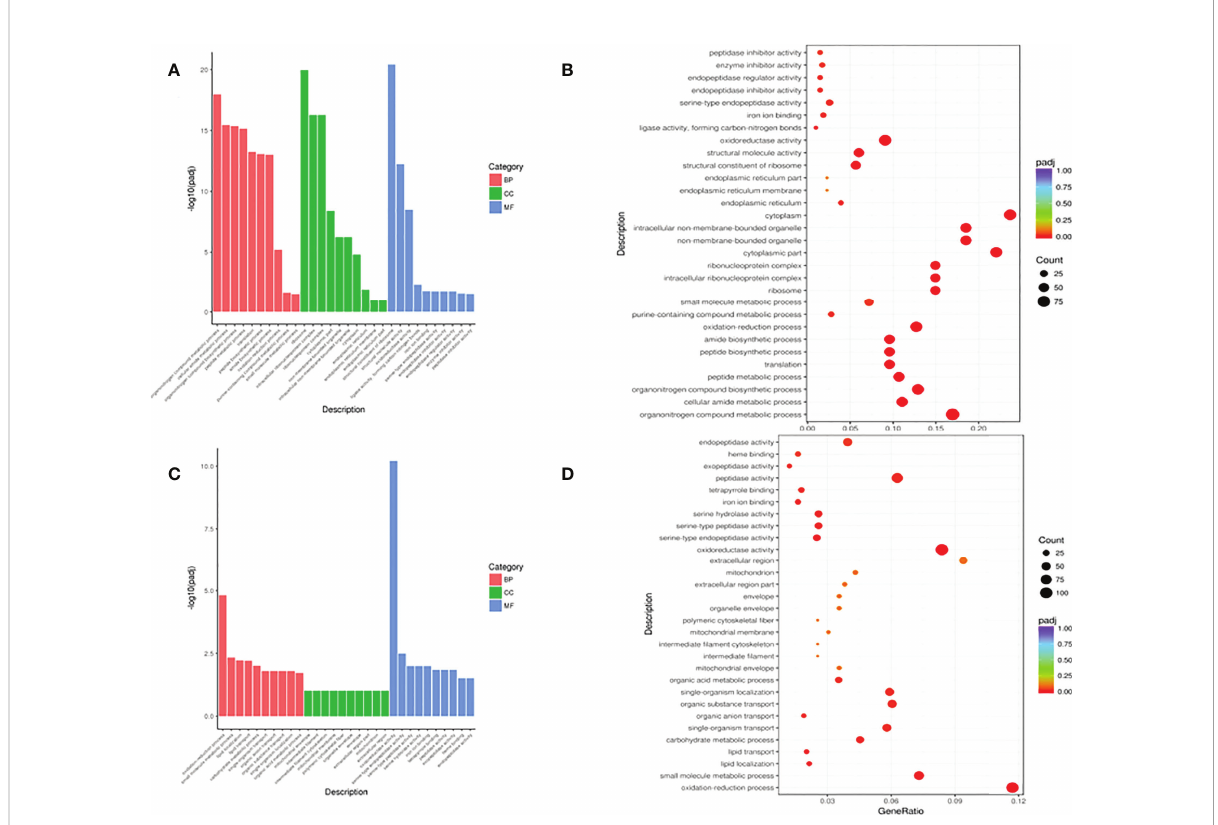
FIGURE 4 Gene ontology (GO) function annotation of DEGs. (A) GO annotation of DEGs in the control versus starvation groups; (B) Scatter plot of GO enrichment analysis of DEGs in the control versus starvation groups; (C) GO analysis of DEGs in the re-feeding versus starvation groups; (D) Scatter plot of GO enrichment analysis of DEGs in the re-feeding and starvation